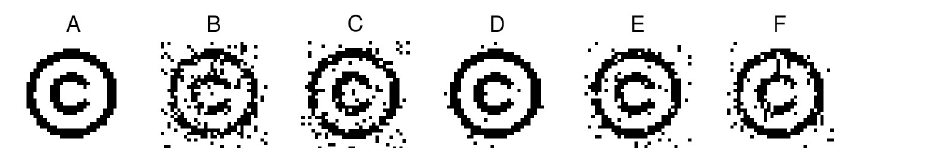
Fig 3. DCT scheme used to extract the watermark images.